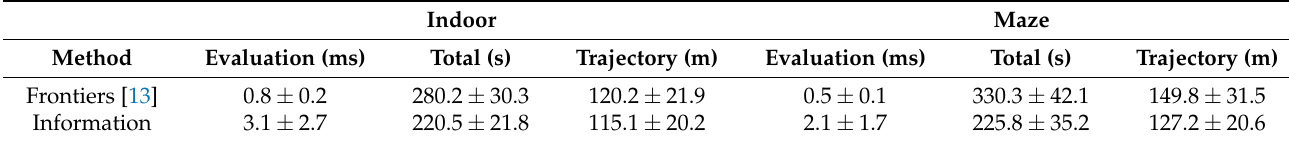
Table 2. Comparison of evaluation method.